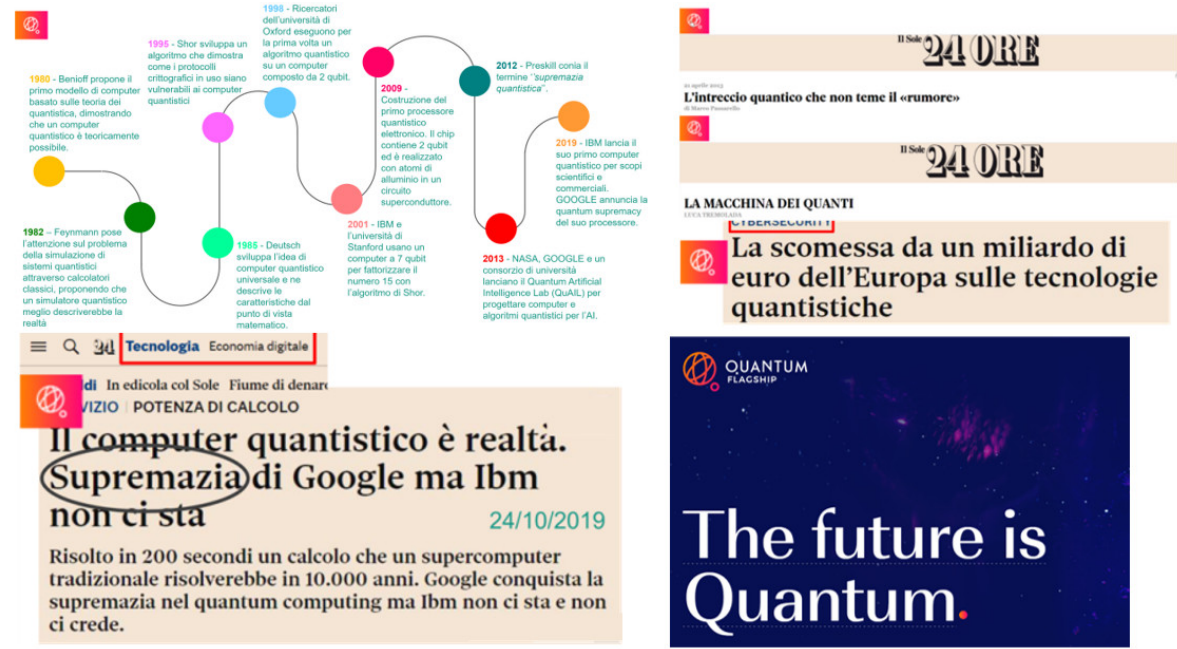
Figure A6. Examples from the final lecture. Screenshots of the slides used during the lecture. Top left: timeline of quantum computer technology. Top right and bottom-left: examples of newspaper titles on quantum computers. Bottom-right: image from the website of the Quantum Technology Flagship .